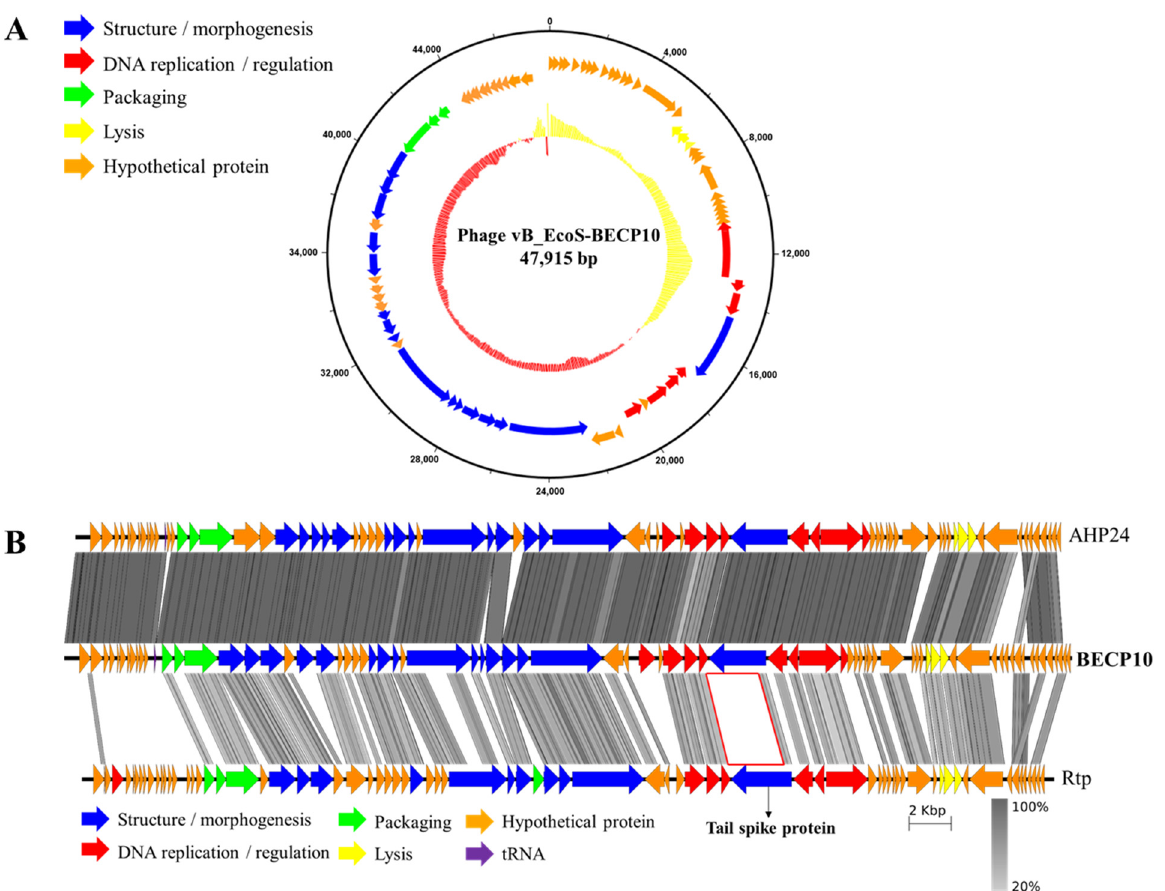
Figure 2. Genome map and comparative genomic analysis of phage BECP10. ( A ) On the inner ring, percentage GC is shown relative to the mean GC content of the genome. A high GC content is indicated in red and a low GC content is indicated in yellow. Outer circle indicates predicted coding DNA sequences (CDSs). ( B ) Comparative genomic analysis of the phages AHP24, BECP10, and Rtp, using the Easyfig tBlastX mode. Coding regions are represented by colored arrows. The gray-scaled shaded area indicates the different levels of amino acid similarity among the phage sequences. Scale unit means base pair. In both figures, the color of each gene indicates the functional category; categories are shown on the left or below the map.